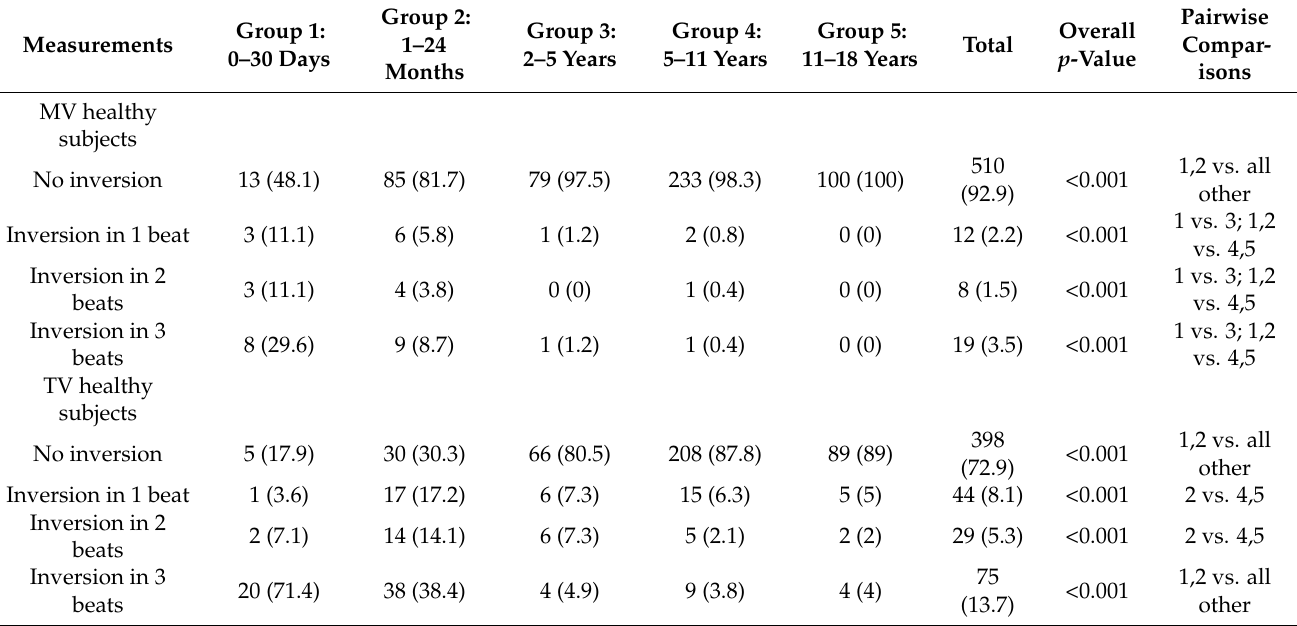
Table 4. Mitral (MV) and tricuspid valve (TV) inflow E/A inversion in healthy